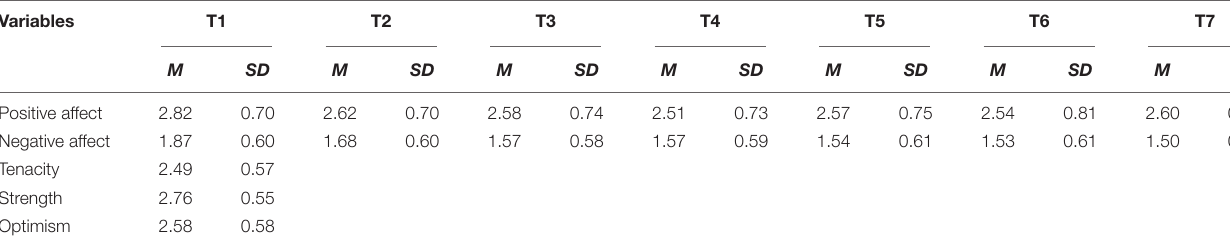
TABLE 1 | Means and standard deviations for main study variables ( N = 391).